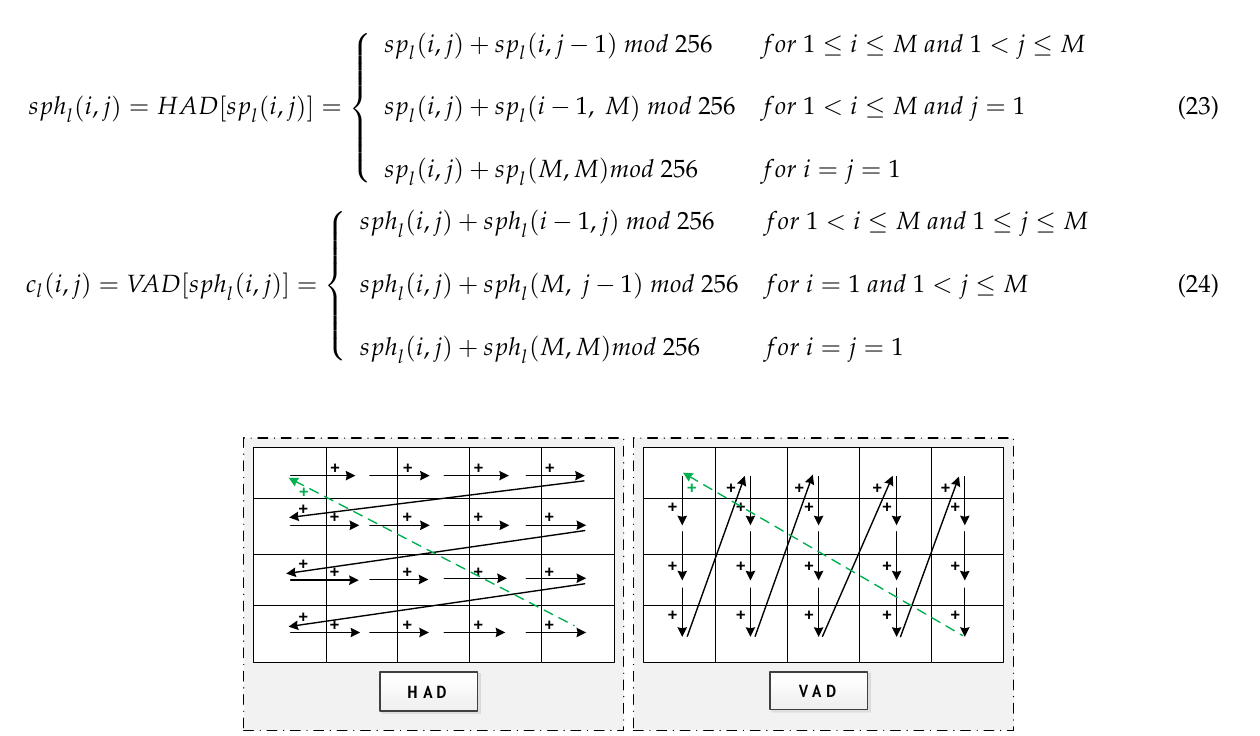
Figure 5. Horizontal and vertical addition